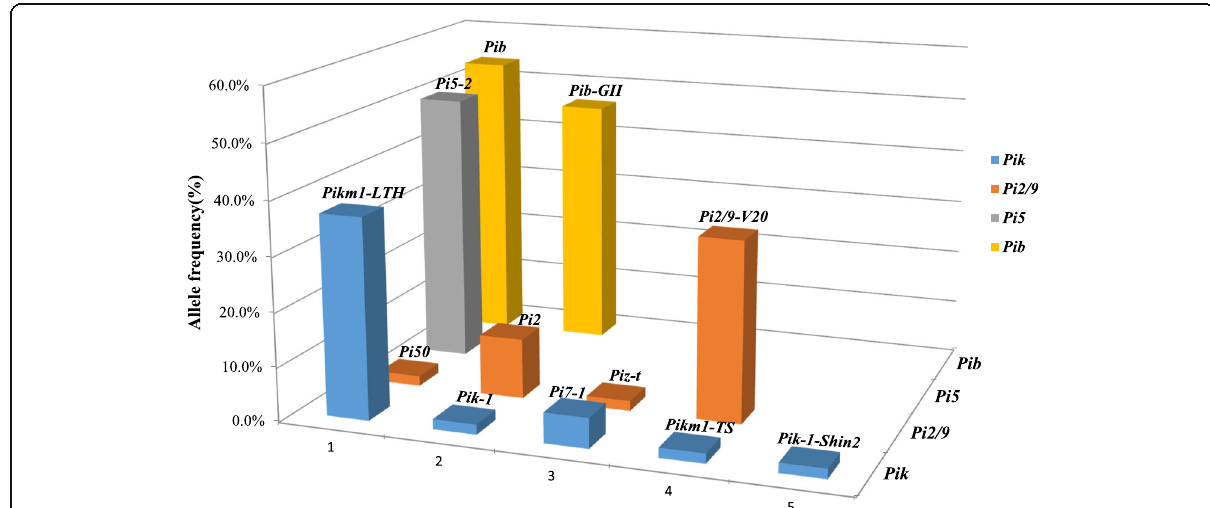
Fig. 1 Frequency of different haplotype in 4 R -gene loci. The frequency of alleles was calculated based on percentage of the number of varieties containing the respective R -gene haplotypes in 54 rice varieties. The designation of R -gene haplotypes on the top of each column can be found in Table 1. Different R -gene loci are indicated in different colored